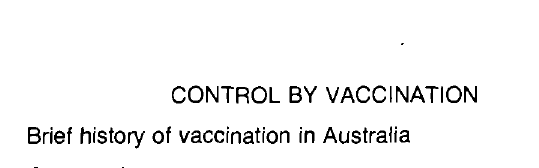
Table 2: MORBIDITY AND MORTALITY DUE TO BABESIA BOVIS OR BABESIA BIG EMINA IN WELL-DOCUMENTED OUTBREAKS OF BABESIOSIS DURING 1974-1976 Number of Cattle at Outbreaks Risk % Sick %